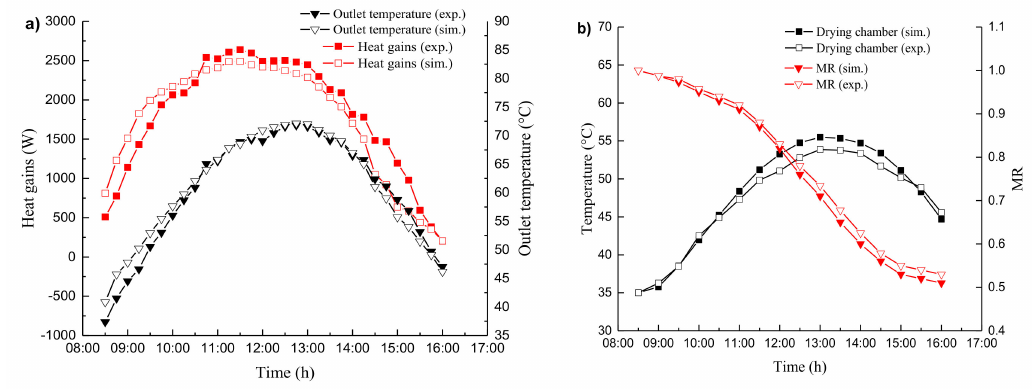
Figure 10. Comparison of experimental and simulated outlet temperature, heat gains chamber ( a ) temperature and moisture ratio ( b ) of wolfberry in stand-alone solar